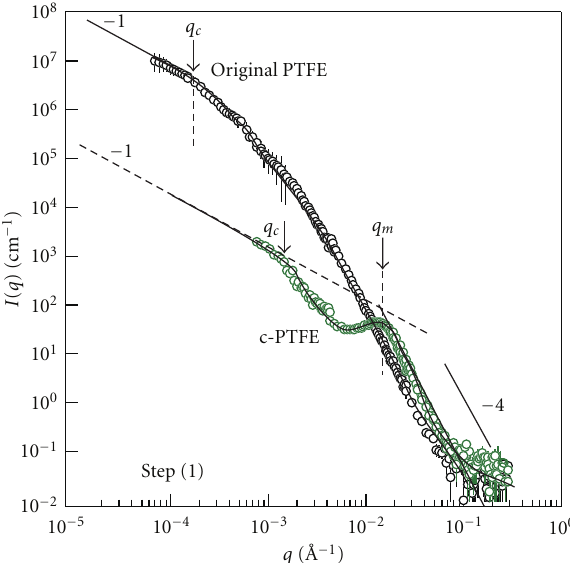
Figure 5: SANS obtained for crosslinked (c-PTFE) and original PTFE without crosslink (PTFE) films (solid lines are guides for eye). A crossover q from q − 1 to a steeper power law is indicated by an arrow with q c .